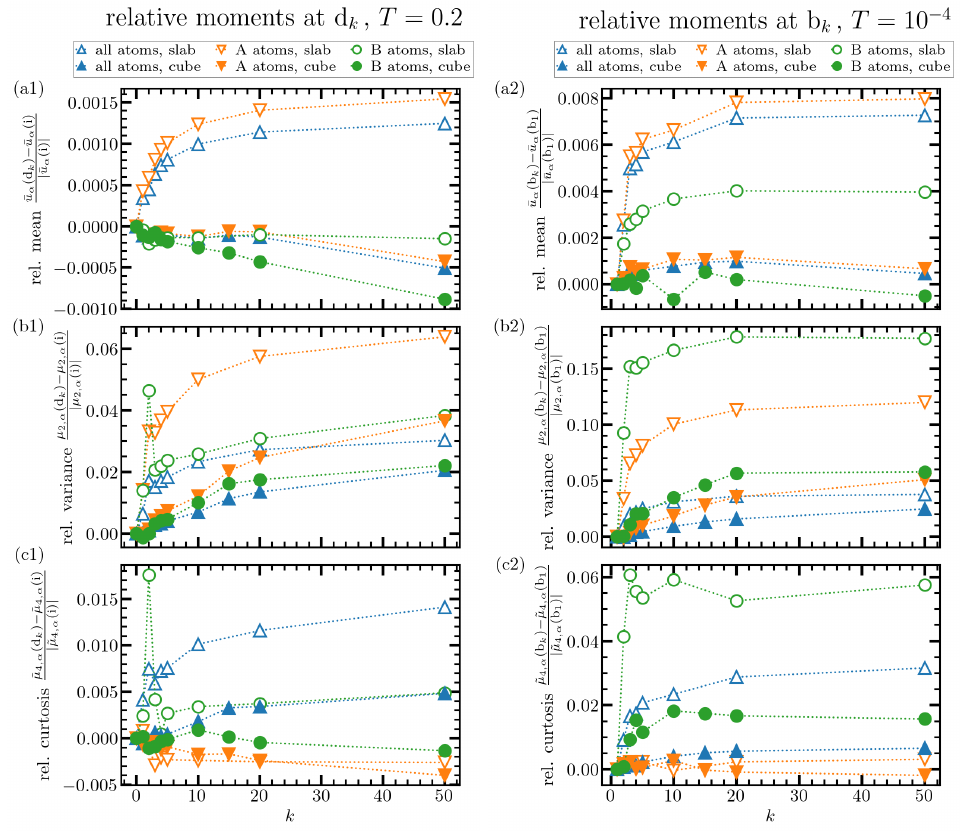
Figure 7. Moments of per-atom potential energy distributions. Relative mean variance and curtosis of the per-particle potential energy distributions after stopping TC at points d k ( a1 – c1 ), b k ( a2 – c2 ), respectively. An additional relaxation time of 10 4 t LJ has been applied before evaluating potential energies to account for the damping of TC induced pressure oscillations. Data for A-particles, B- particles and all particles can be found as indicated in the legends. In all the cases shown, the strongest TC-effects occur for the lower cycling temperature ( T = 10 − 4 ≈ 0.00024 T g ) and in the longer system